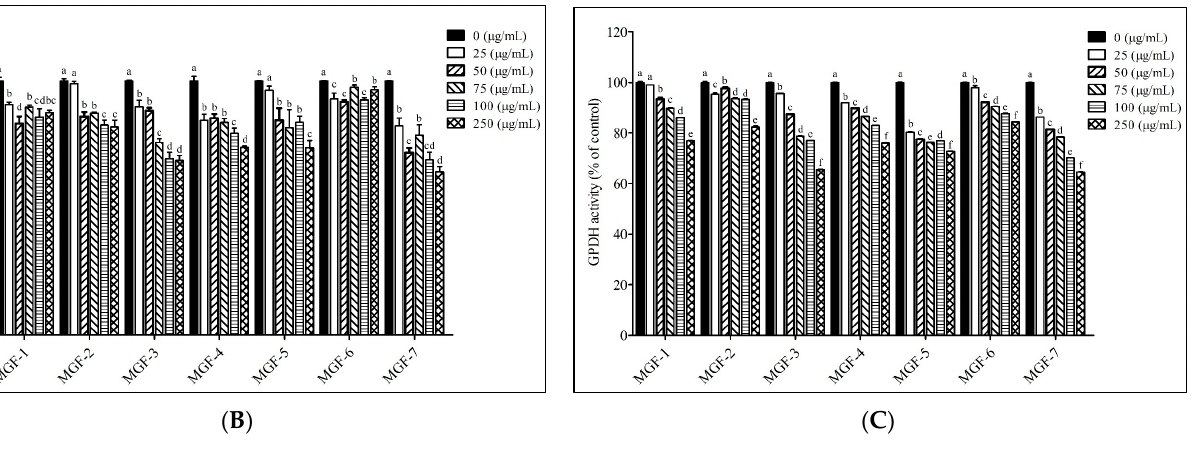
Figure 2. Effects of MGF-1-7 on the adipogenesis in 3T3-L1 adipocytes. ( A ) Quantification of the lipid droplets in 3T3-L1 adipocytes stained with oil-red O-stained material (OROSM). 3T3-L1 adipocytes were treated with MGF-1-7 (0–250 μ g/mL) for 48 h at 37 °C in a 5% CO 2 incubator. ( B ) Quantification of intracellular triglyceride levels in 3T3-L1 adipocytes. ( C ) Relative activity of GPDH in 3T3-L1 adipocytes. All values are presented as mean ± SEM. The percentage (%) of variables was estimated by comparing it with the control group. The values with different letters indicated a significant change between groups as determined by one-way ANOVA with post hoc Duncan’s test. Differences were considered statistically significant when p < 0.05.